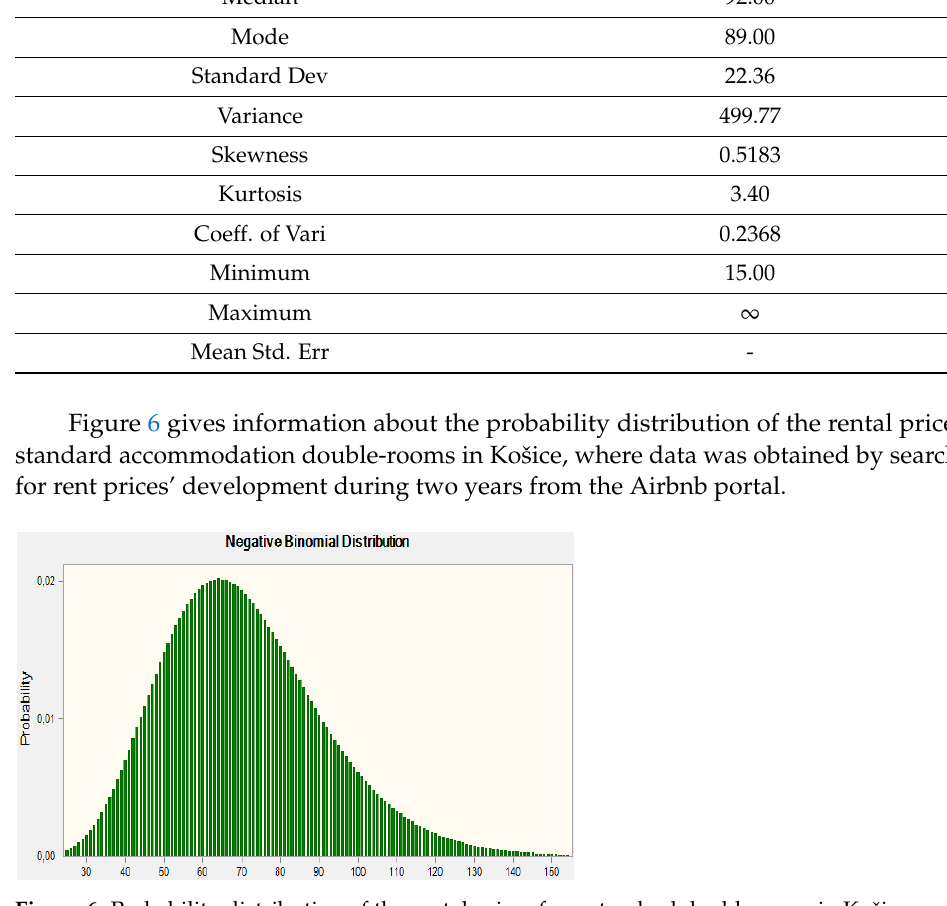
Table 6. Descriptive statistics of the probability distribution for rent prices of a standard dou- ble-room in Košice.